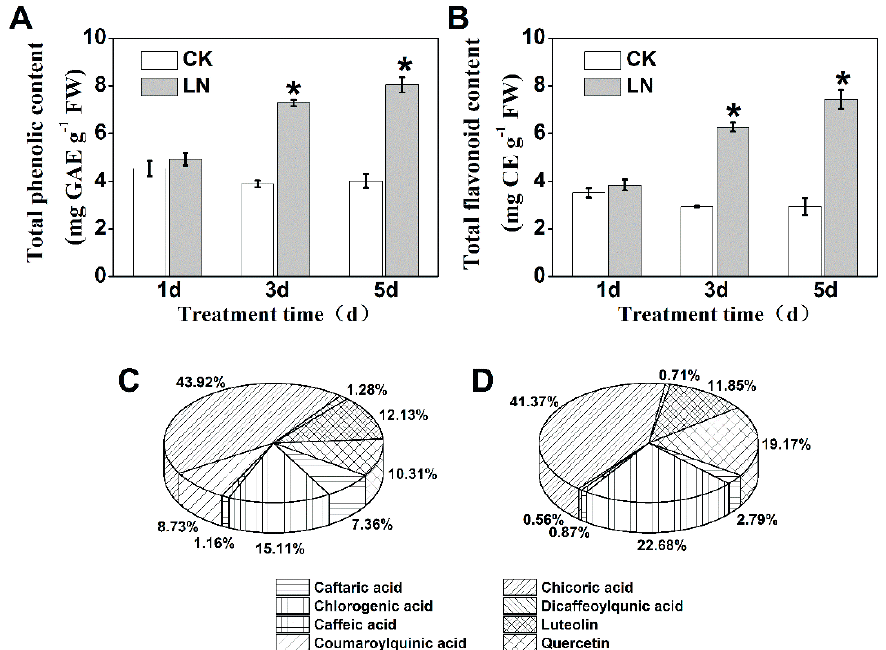
Figure 1. ( A ) Total phenolic content and ( B ) flavonoid content in lettuce cultivated under adequate (CK) or low nitrogen solution (LN). The percentage contribution of individual phenolic compounds to the total phenolics in lettuce extracts after 5 days of CK ( C ) or LN treatment ( D ). Data represent means ± SD (n = 6). * indicates significant di ff erence at P < 0.05 between LN and CK.